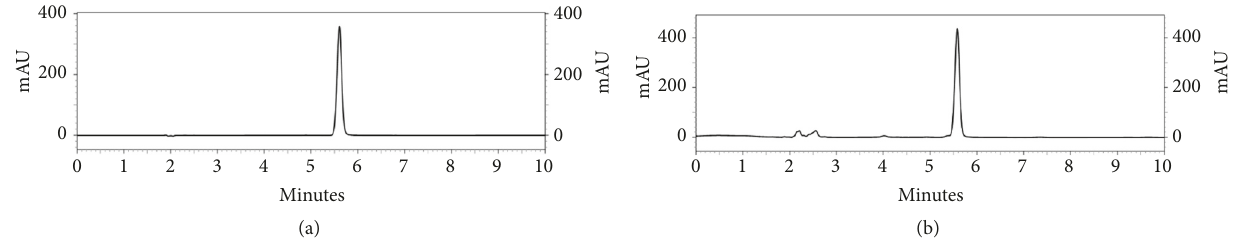
Figure 1: HPLC chromatograms of (a) nitrate (50 𝜇 g/mL) and (b) V. cinerea extract extracted from condition 9 (2 mg/mL).